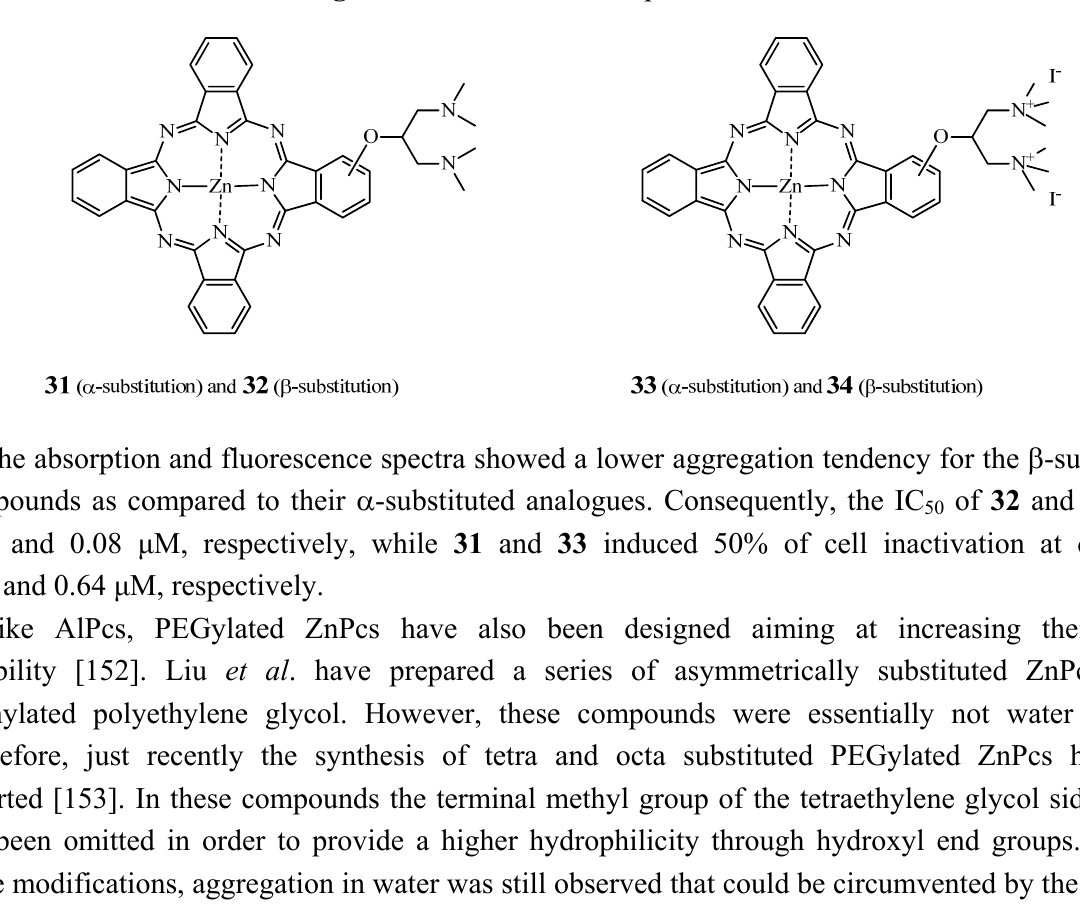
Figure 13. Structure of compounds 31–34